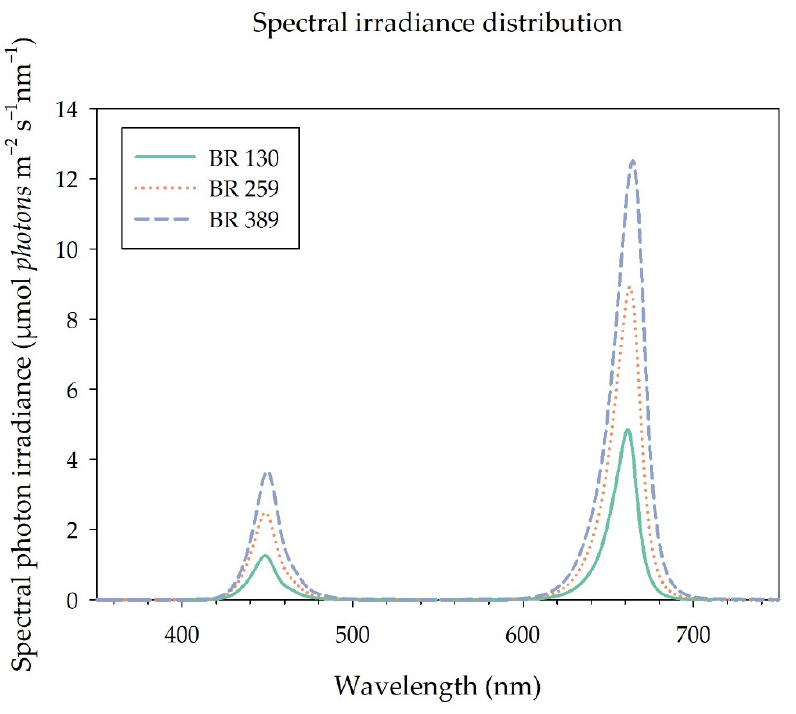
Figure 1. Spectral distribution of the BR LED light used in the study light (GreenPower LED dy- namic module, Signify, Eindhoven, The Netherlands). Photosynthetic Flux Density at canopy level (PPFD) of 130 µmol m − 2 s − 1 (BR 130, DLI 7.49 mol m − 2 d − 1 ), 259 µmol m − 2 s − 1 (BR 259, DLI 14.92 mol m − 2 d − 1 ), and 389 µmol m − 2 s − 1 (BR 389, DLI 22.41 mol m − 2 d − 1 ). 14.92 mol m − 2 d − 1 ), and 389 µ mol m − 2 s − 1 (BR 389, DLI 22.41 mol m − 2 d − 1